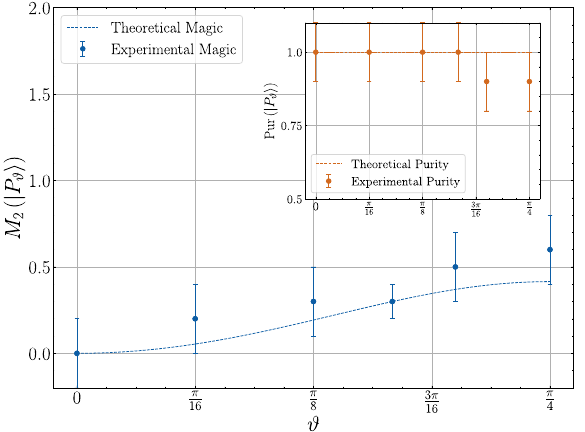
Fig. 2 Stabilizer 2-Rényi entropy for P ϑ j i . Plot of the magic of the single qubit P ϑ j i -states, for θ ¼ 0 ; π (blue dots) are obtained from the quantum processor ibmq_quito. The blue dashed curve represents the theoretical value of the magic for P ϑ j i -states, i.e. M 2 ð P ϑ j iÞ ¼ 3 (cid:2) log plot of the purity for these states is displayed in the upper right corner: as the data show, the purity is 1 within the experimental errors, showing that the decoherence affecting the system is negligible for n = 1 and also the experimental values of magic are in perfect agreement with the theoretical ones. See Supplementary Table II in the Supplementary Note 4 for the data.